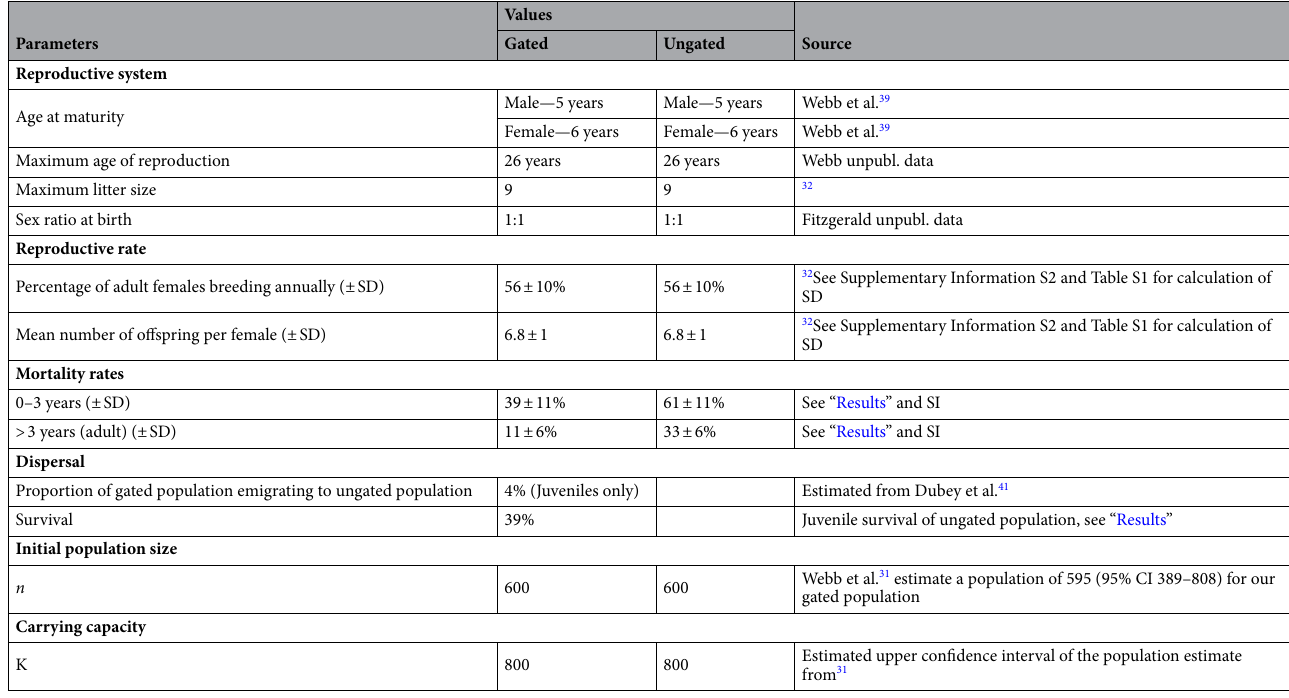
Table 1. Life history parameters used in the base scenario for population viability analysis (PVA) of gated and ungated populations of broad-headed snakes in Morton National Park, New South Wales,